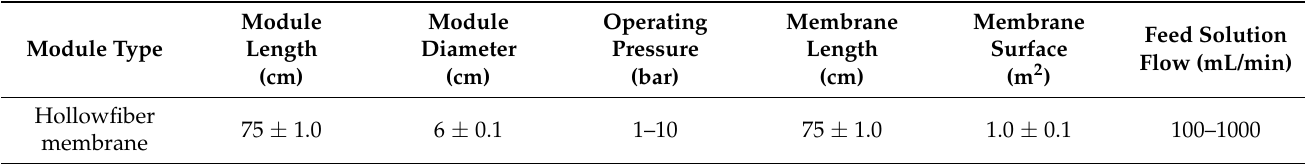
Table 2. The characteristics of the nanofiltration installation